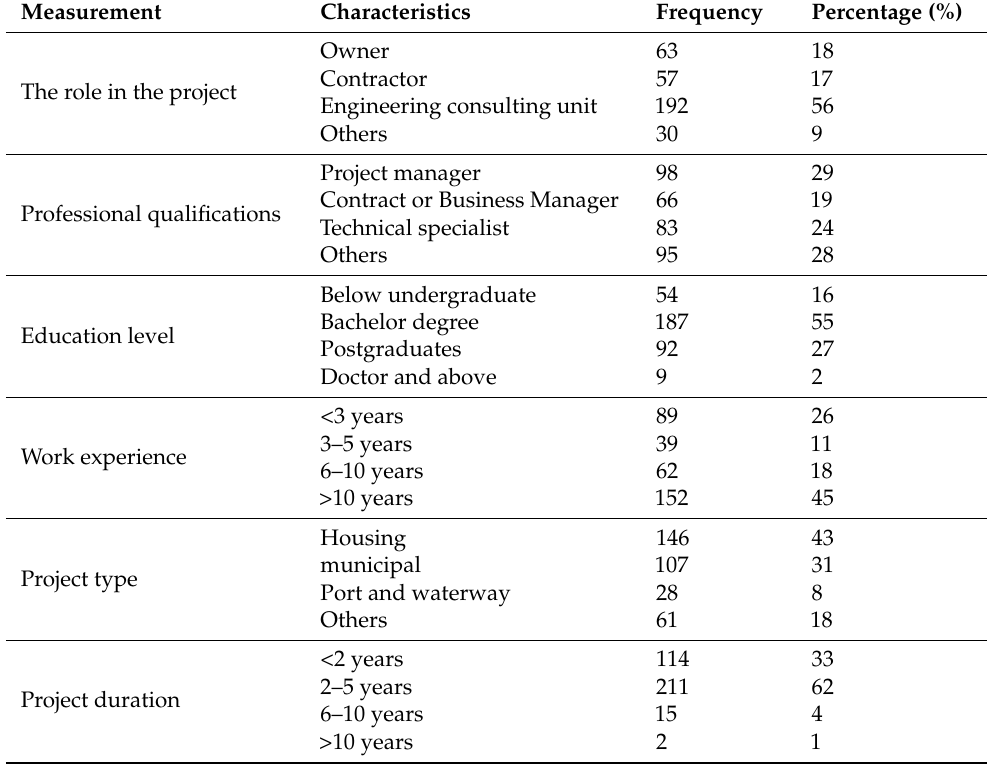
Table 1. Demographic Characteristics of the